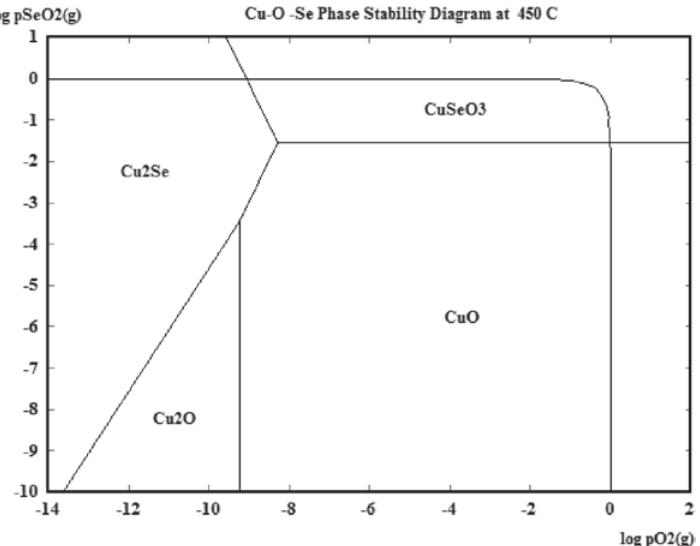
Fig. 6: The stable phases in the system Cu-Se-O at a typical selenium roasting temperature of 450 °C, as a function of the prevailing oxygen partial pressure of the system; the solid curve shows the atmospheric composition of 1 atm total pressure expressed as P O forming a boundary condition of the industrial selenium roasting.